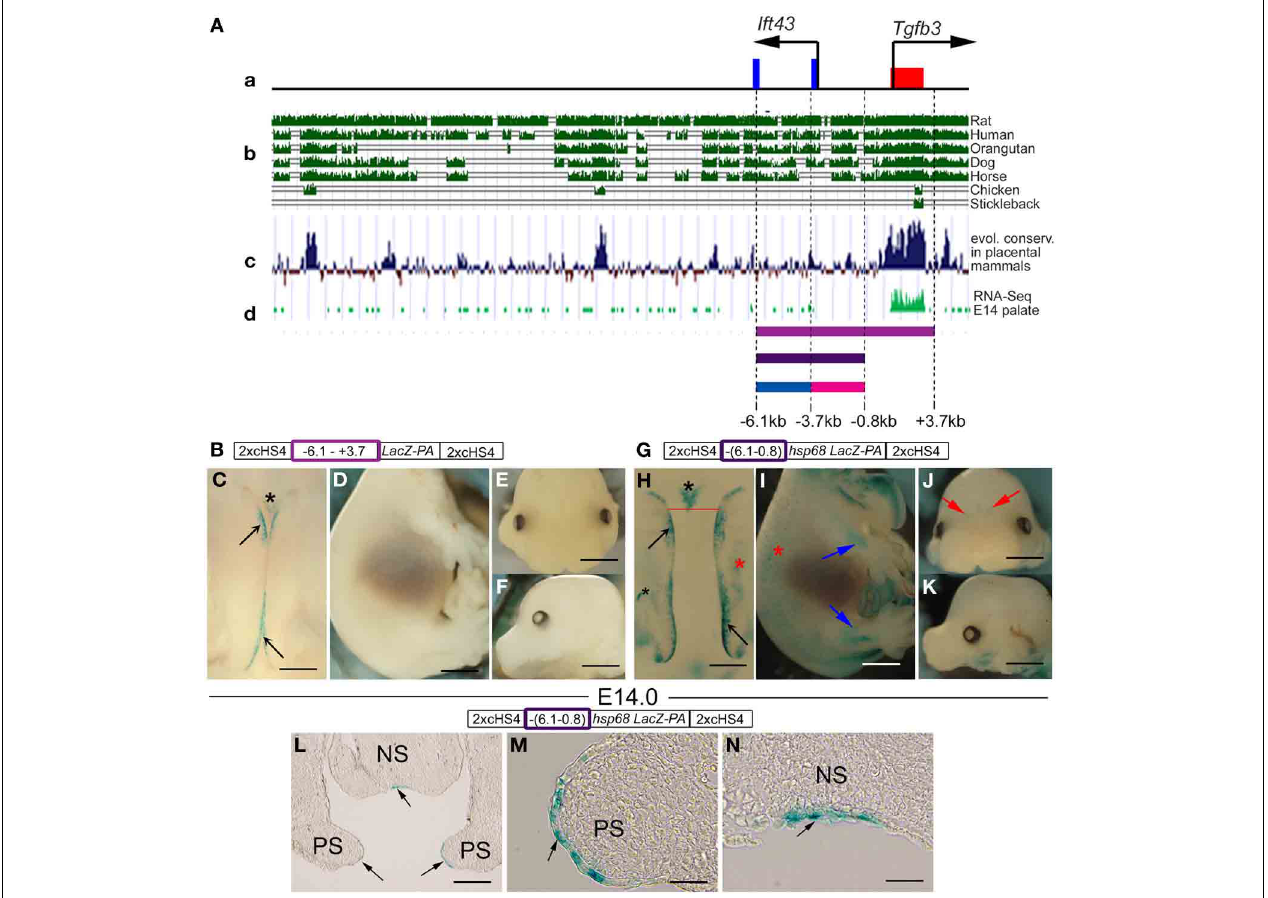
FIGURE 7 | A putative proximal enhancer directing palatal expression lies in a 5.3-kb region upstream of the Tgfb3 gene. (A) Schematic representation (a) of a 28-kb region upstream of Tgfb3 exon 1 (red box) including Ift43 exons 1 and 2 (blue boxes) aligned with (b) evolutionary conservation among selected vertebrate species (ucsc genome browser), (c) evolutionary conservation among the placental mammals (ucsc genome browser), (d) RNA-seq profile in mouse palate at E14.5. Colored bars below (d) correspond to DNA fragments examined using transient transgenic reporter assays (B–N) . (B,G) Schematic presentations of reporter constructs used to generate transgenic embryos [colored rectangles correspond to colored bars shown above (a) ]. (C–F) Transgenic reporter embryo carrying the 9.8-kb DNA fragment from − 6.1 to + 3.7kb (magenta bar above (a) and magenta rectangle in B ) showing β -gal